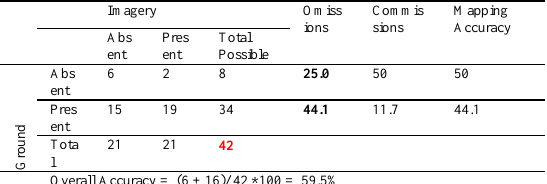
Table 3: Accuracy assessment of Buffel grass mapping comparing on ground data to Worldview-2 image classification of Buffel grass presence and